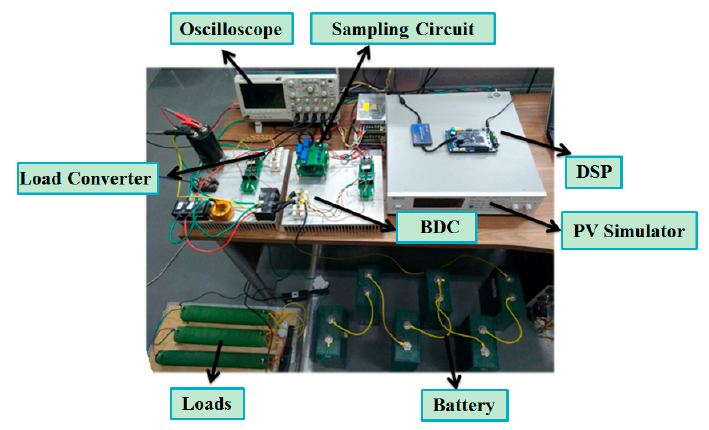
Figure 7. The experimental rig.